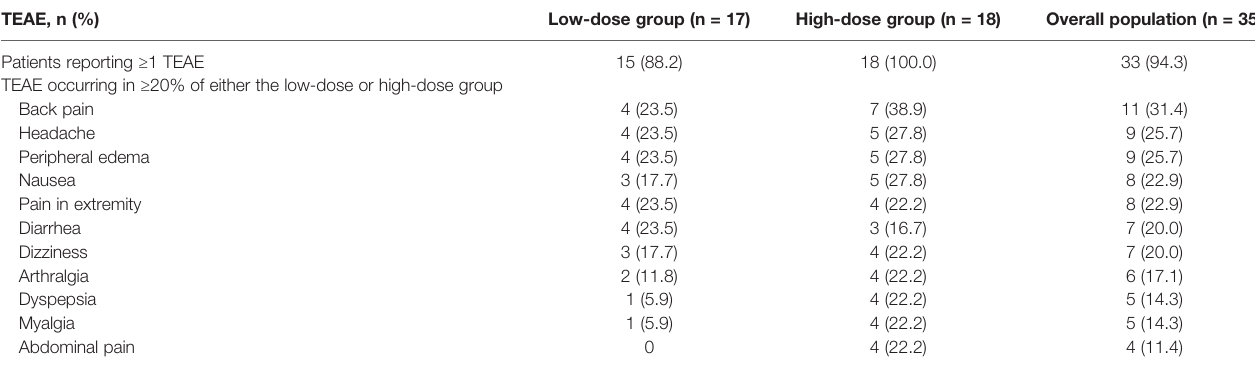
TABLE 5 | TEAEs by preferred term in the safety